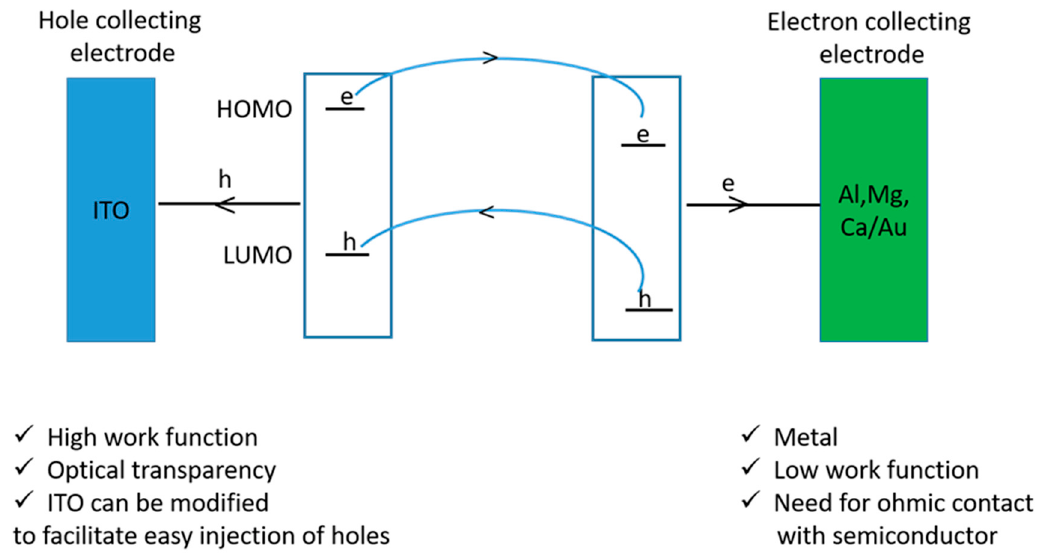
Figure 6. Summary of the events during electron-hole transportation to electrodes.